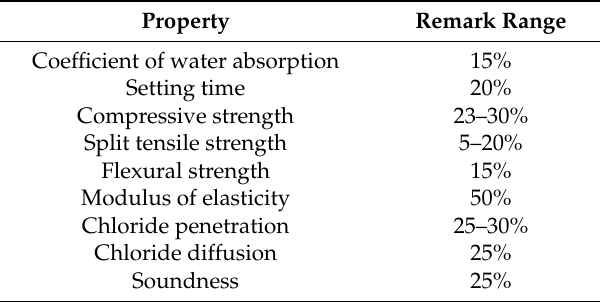
Table 3. Optimal SCBA replacement for different concrete properties